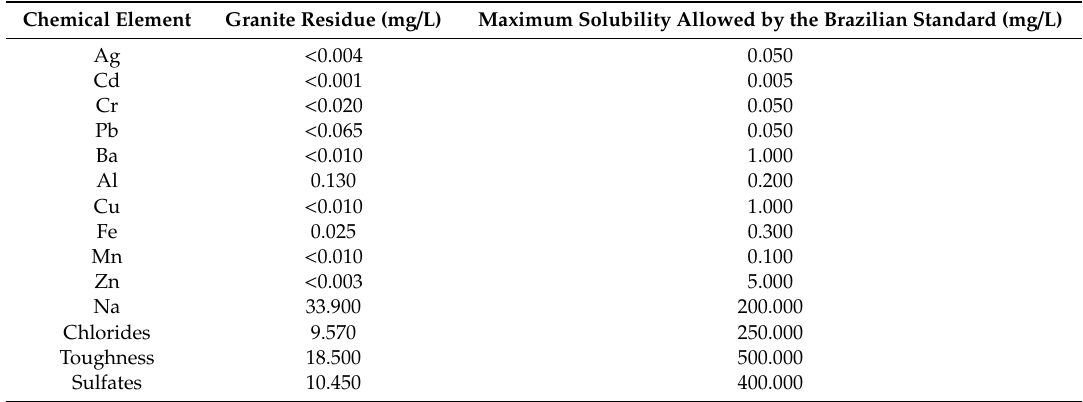
Table 4. Result of the solubilization test of the granite residue.